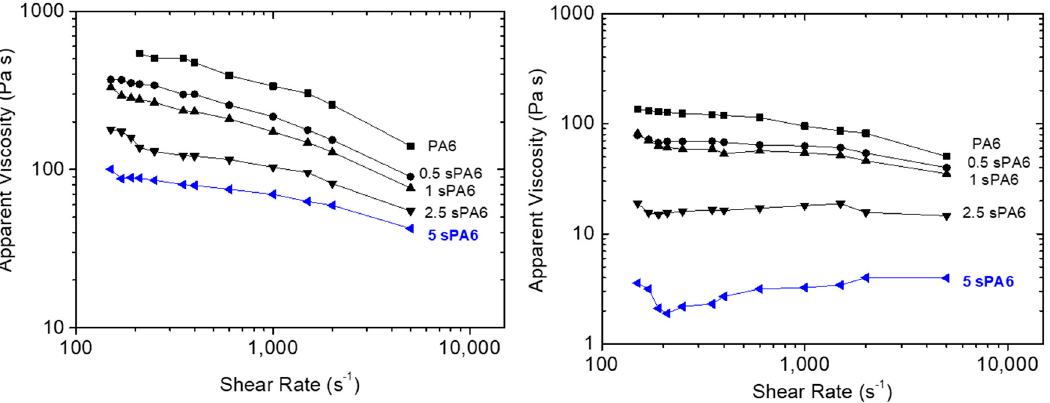
Figure 7. Apparent viscosity of the samples by capillary rheometry versus shear rate: (left) 240 °C and (right) 260 °C.